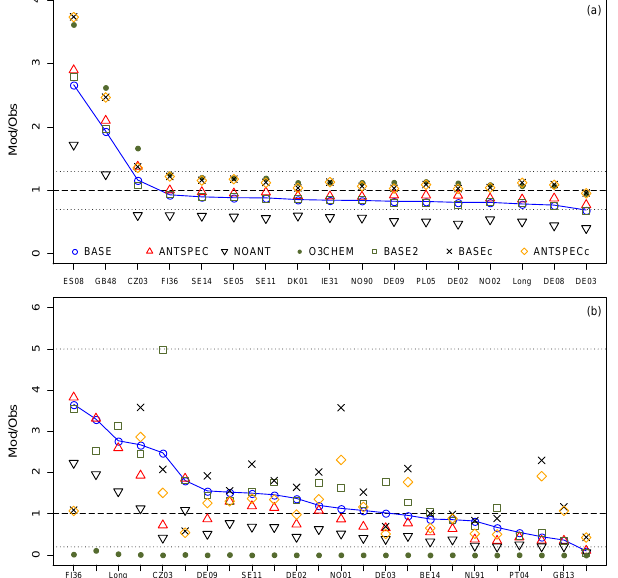
Figure 5. Ratio of the modelled and observed values at the mea- surement station points. (a) GEM concentrations; (b) wet deposition fluxes. Horizontal lines represent perfect agreement (dashed line, ratio = 1) and good agreement intervals (dotted lines, ± 30% for GEM, factor 5 for WD).